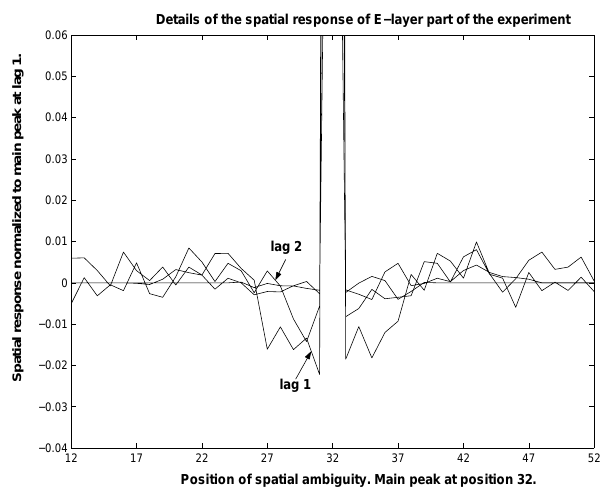
Fig. 3. Details of the spatial response of the E-layer part of the